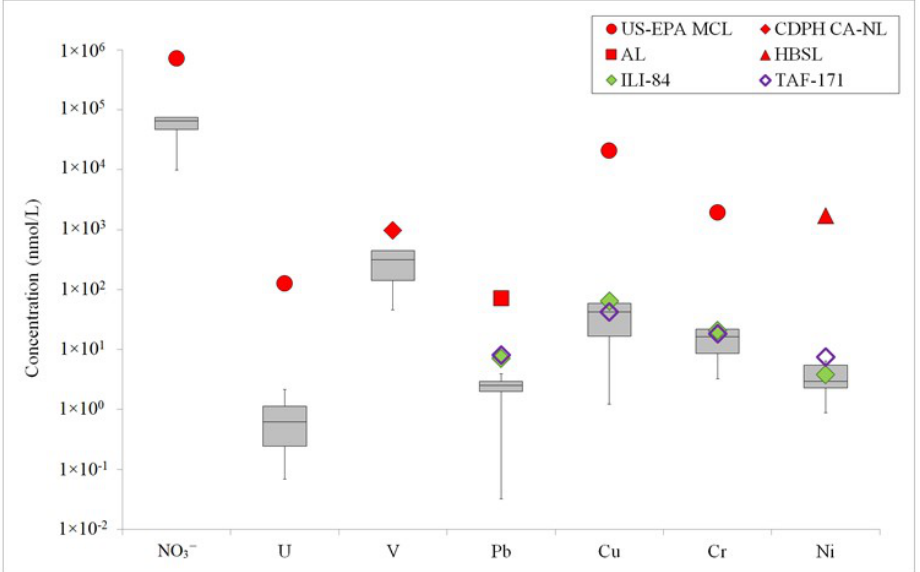
Figure 9. Measurements of potentially harmful groundwater nutrient and trace metals with various drinking water standards (US-EPA MCL: U.S. Environmental Protection Agency maximum contaminant level; CDPH CA-NL: California Department of Public Health notification level; AL: Action Level (concentrations which trigger treatment according to U.S. EPA regulations); HBSL: Health-Based Screening Levels (developed by the U.S. Geological Survey with U.S. EPA data)). Minimum, Q1, median, Q3, and maximum values for Pb, Cu, Cr, and Ni omit the two sample locations with relatively high Pb concentrations ( n = 13). Those two sample locations are instead indicated as green and purple diamonds. Data are in Table